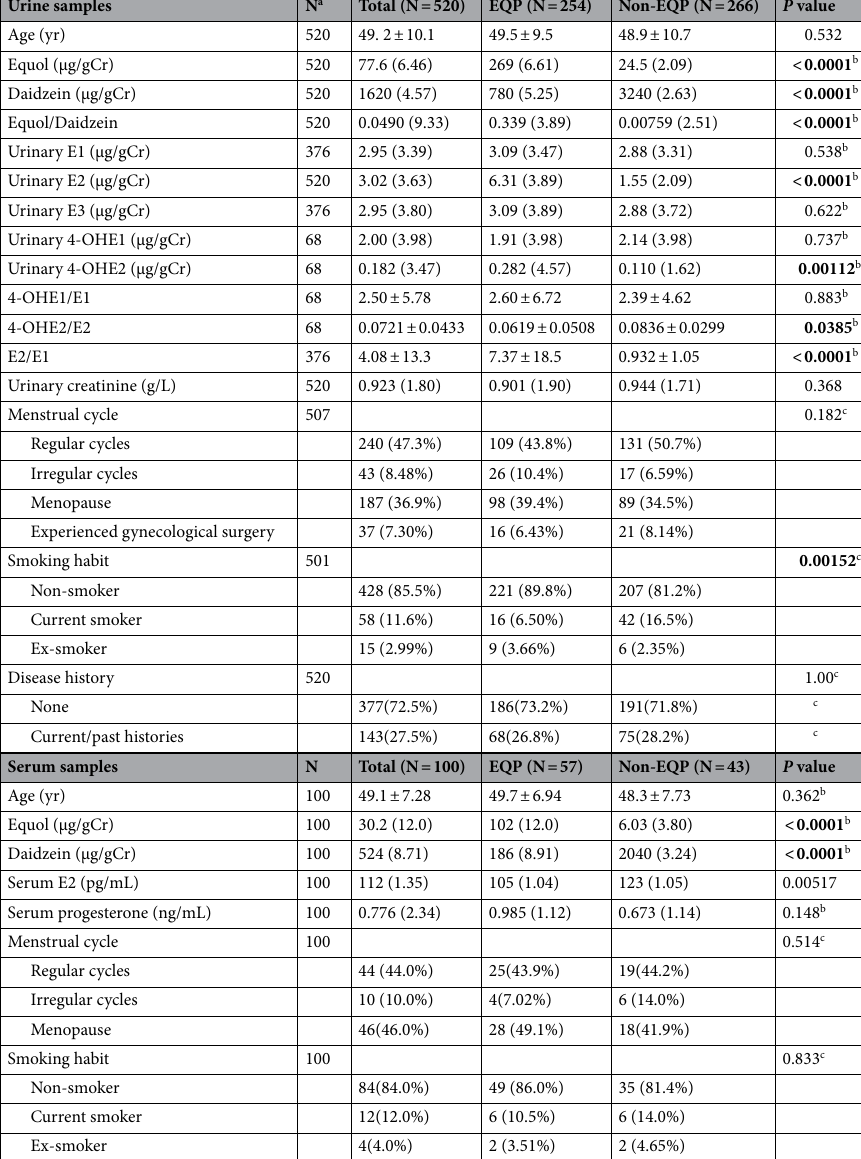
Table 1. Characteristics of the study subjects and their estrogen and isoflavone concentrations. Values of urinary equol, daidzein, E1, E2, E3, 4-OHE1, 4-OHE2, creatinine, serum E2, and progesterone were geometric means and geometric standard deviations. Log: common logarithm; gCr: grams creatinine. a The N for each item varies owing to missing values or selection for additional chemical analyses. b P values indicates